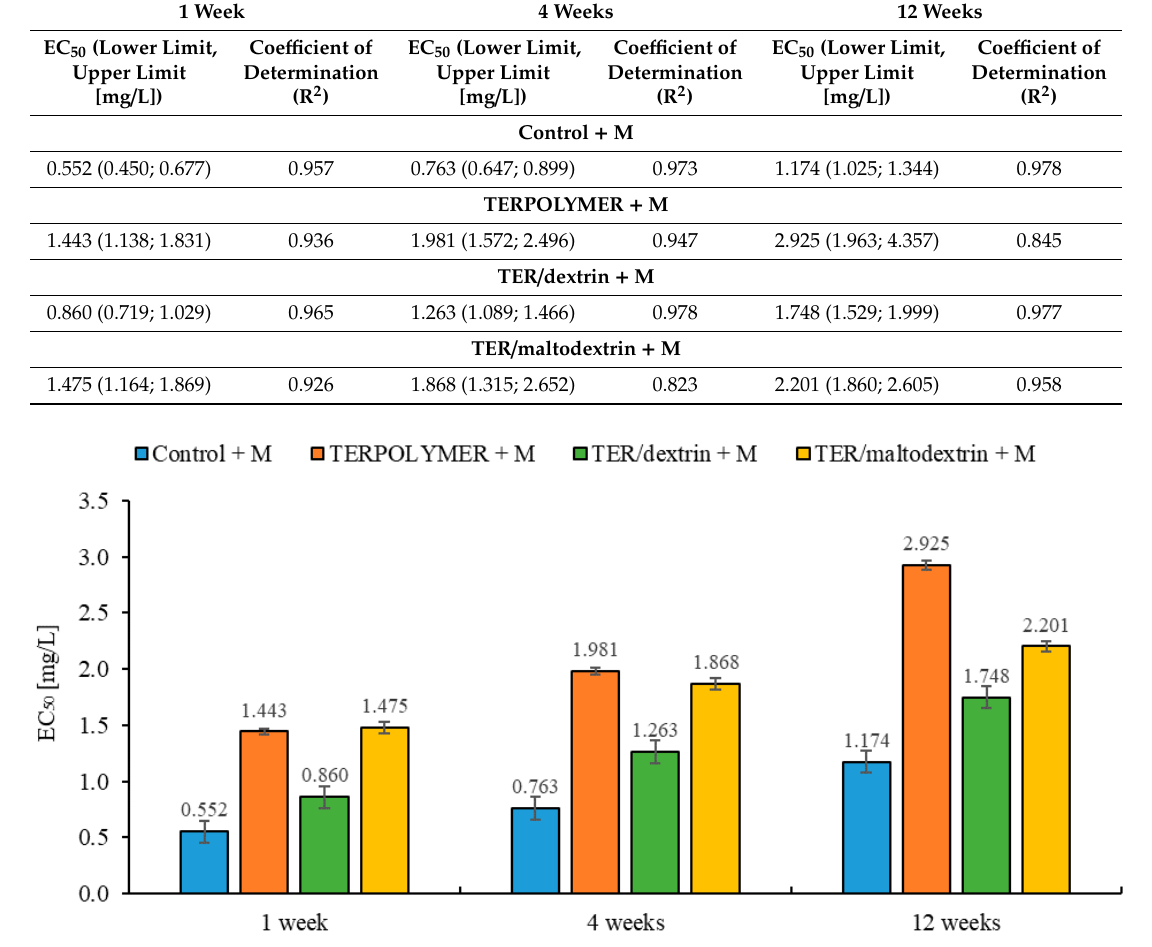
Figure 12. EC 50 values of tested soil with microspheres (TERPOLYMER, TER/dextrin, TER/maltodextrin) loaded with metazachlor measured during exposure to the A. fischeri . As expected, the highest toxicity against A. fischeri was found for soil contaminated with both non-coated herbicides.